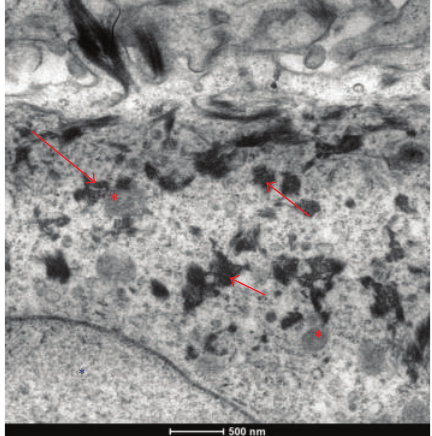
Figure5:TEMimagesofAgNps(redarrows)incytoplasmaticspace of fibroblast present in a healed skin sample treated with AgNP based medical devices. AgNP are closed to the mitochondria (red ∗ ); nuclei is indicated by blue ∗